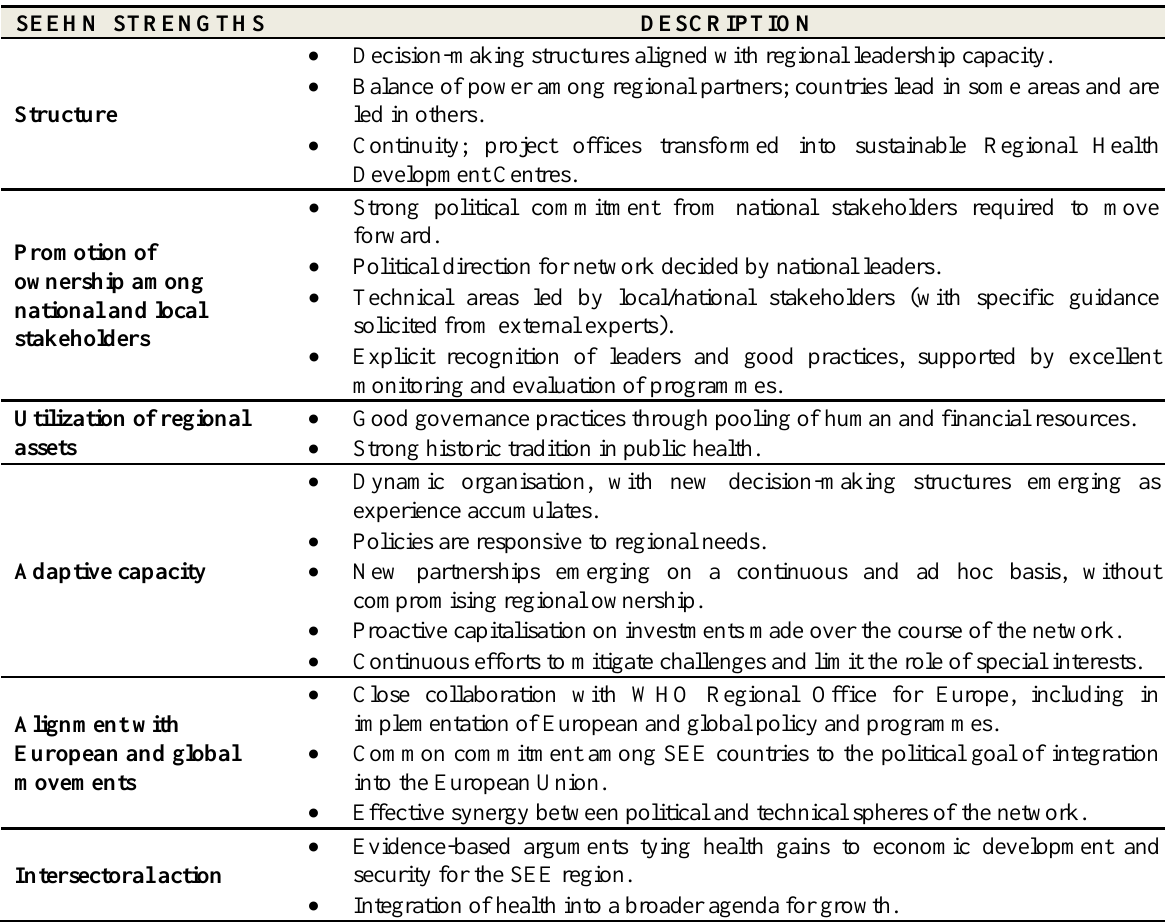
Table 2. Keys to success in the South Eastern Europe Health